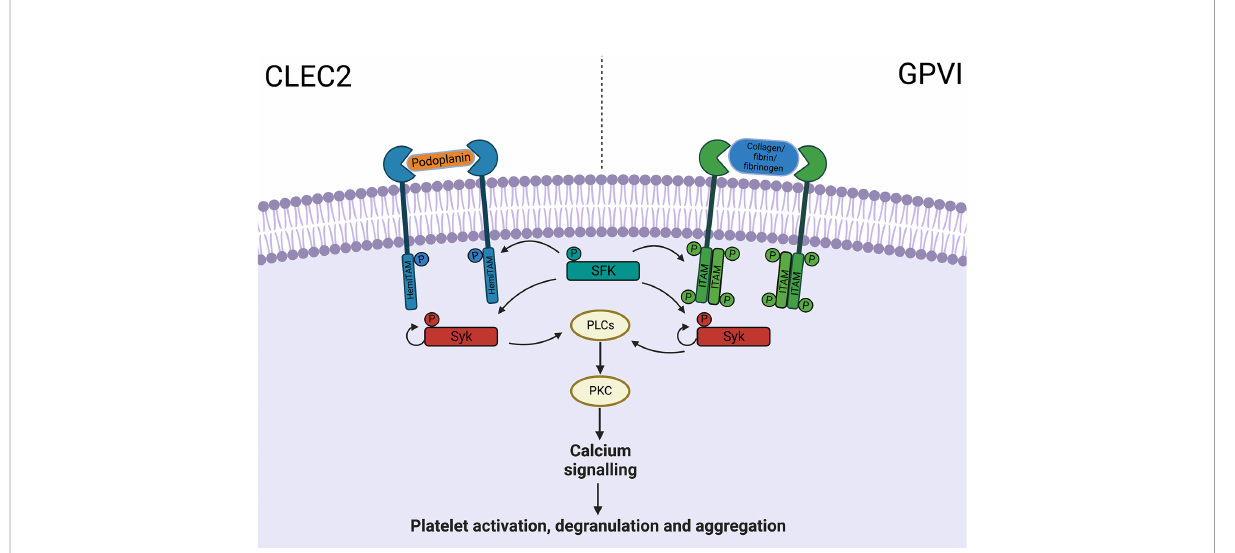
FIGURE 2 ITAM receptor downstream signalling pathway. CLEC-2 and GPVI share common downstream pathways, with activation leading to platelet aggregation and degranulation, through PLC, PKC and calcium signalling. C-type lectin-like receptor 2, CLEC2; Glycoprotein VI, GPVI; Immunoreceptor tyrosine-based activation motif, ITAM; Phosphate, P; Src family kinase, SFK; Phospholipase C, PLC; Protein kinase C, PKC